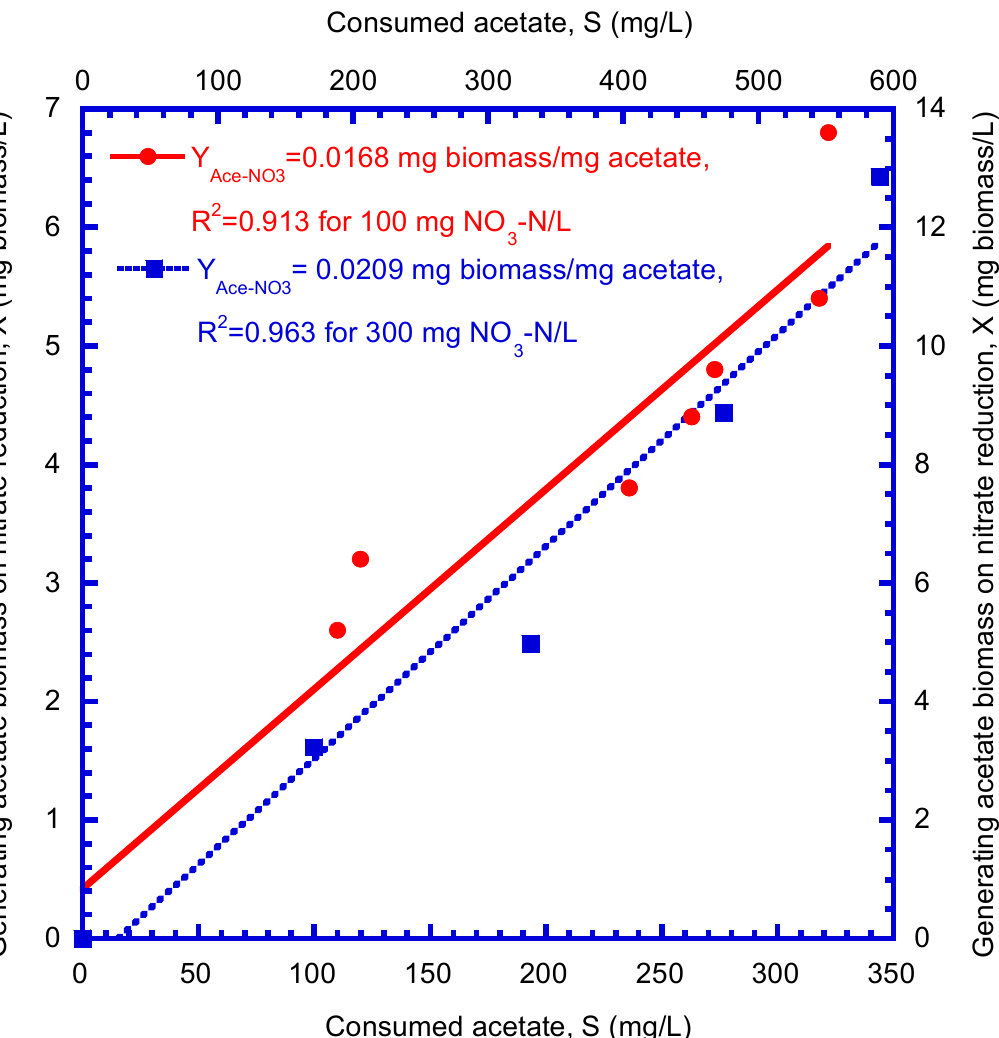
Figure 6. Batch kinetic test to determine acetate biomass yield at different initial nitrate concentrations of 100 and 300 mg NO 3 -N/L. of 100 and 300 mg NO 3 -N /